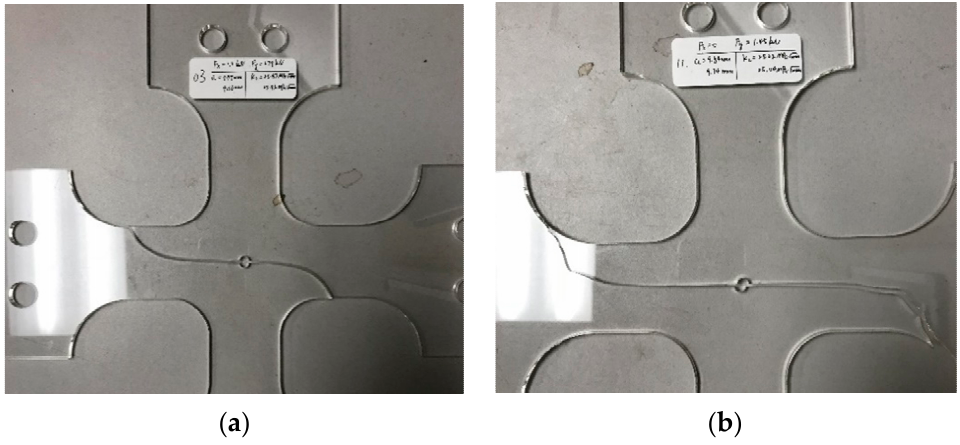
x = 1.21 kN ( b ) F x = 0.98 kN.